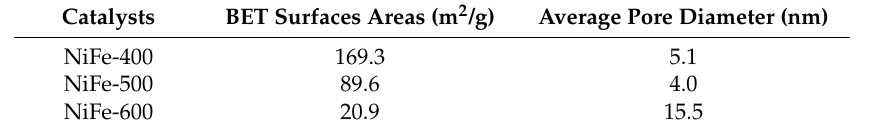
Table 1. Brunauer–Emmett–Teller (BET) surface areas and average pore diameter of the samples.